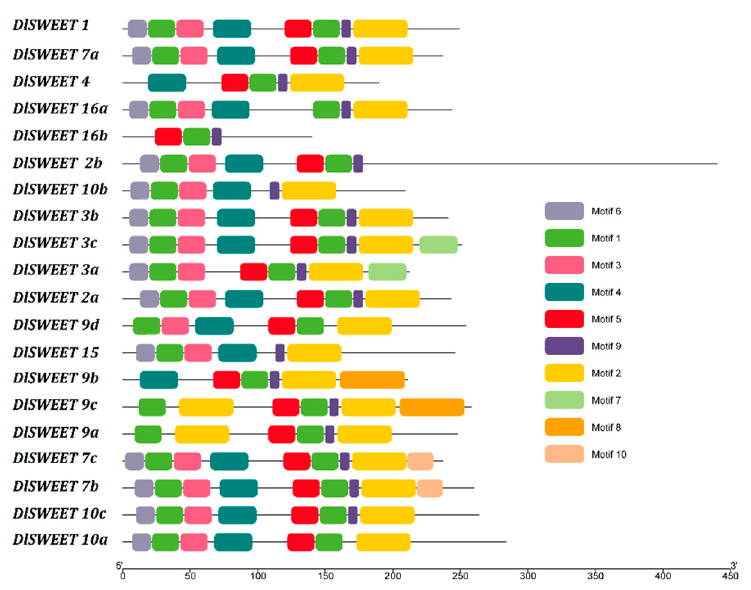
Figure 2. Conserved motif analysis of DlSWEET proteins.